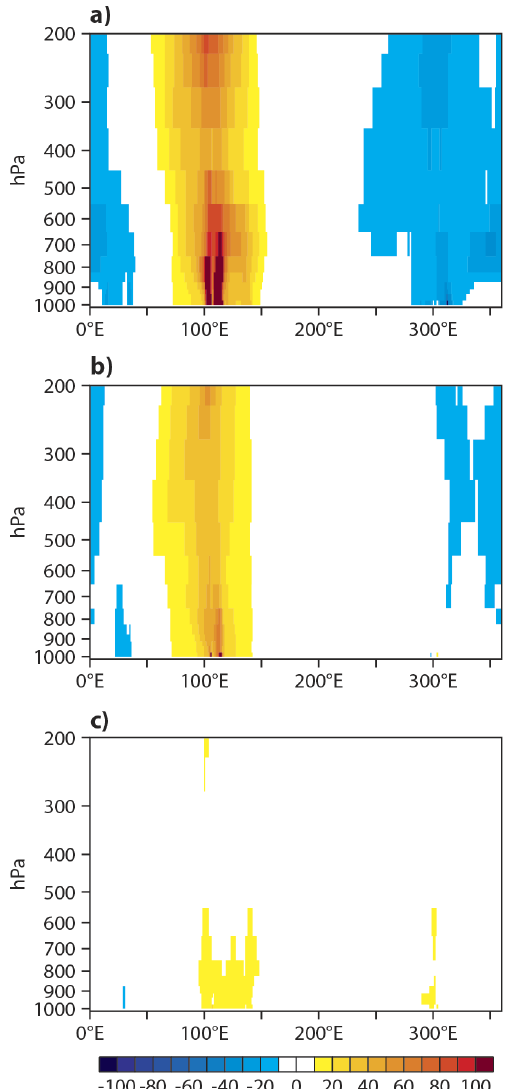
Figure 10. The same as Fig. 9 but for CO in